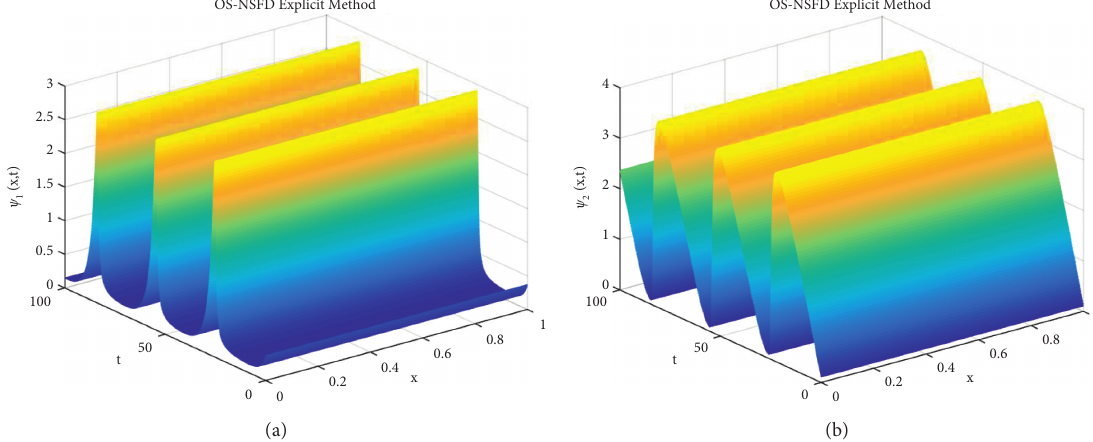
Figure 18: Mesh graphs of ψ (a) Mesh graph of ψ